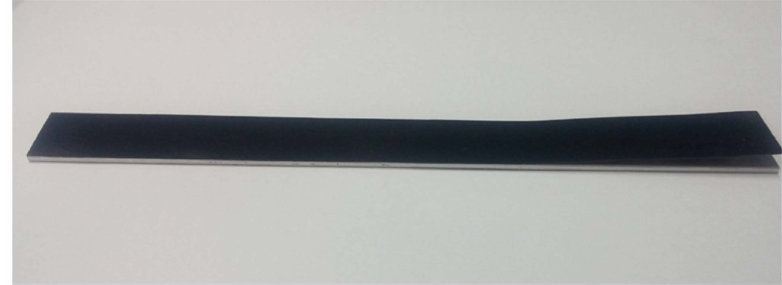
Figure 4. ENF specimen with an interfacial edge crack.